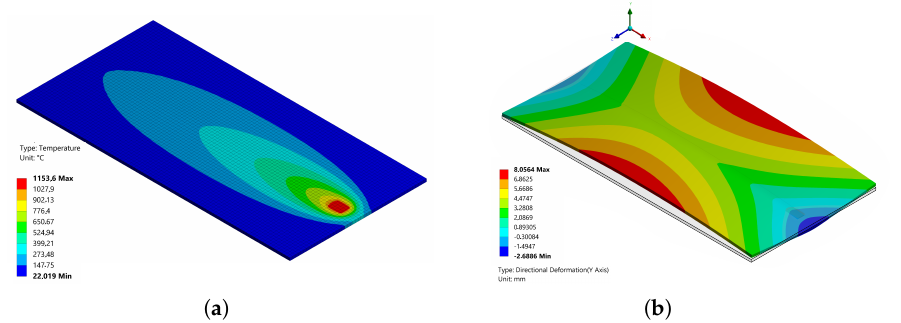
Figure 9. ( a ) Temperature (ºC) and ( b ) boundary conditions and vertical displacement (mm) contours in the Dye model.